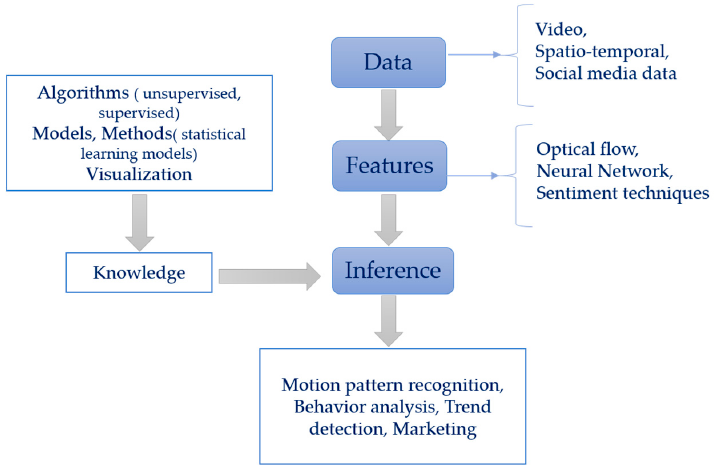
Figure 11. Structure of crowd analysis.